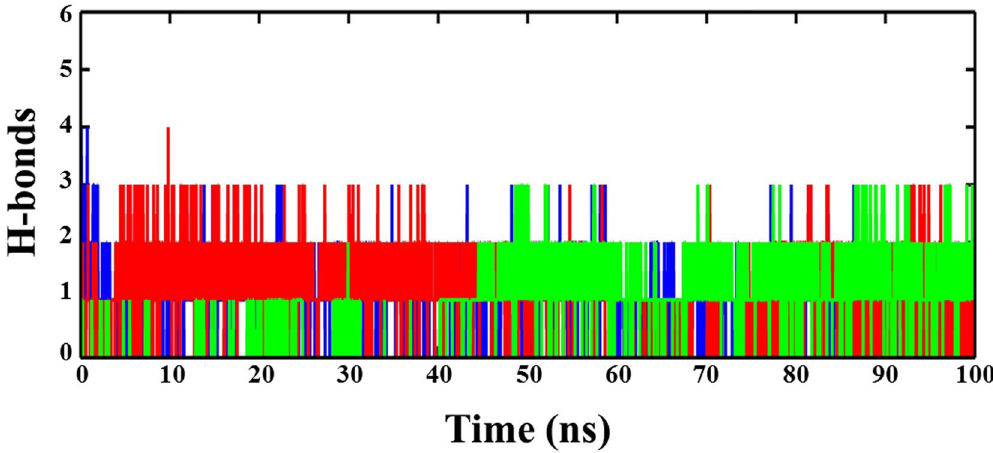
Figure 5. The time evolution plots of H-bond interactions between ACE2 with ligands NF1 (blue), NF12 (red), and NF13